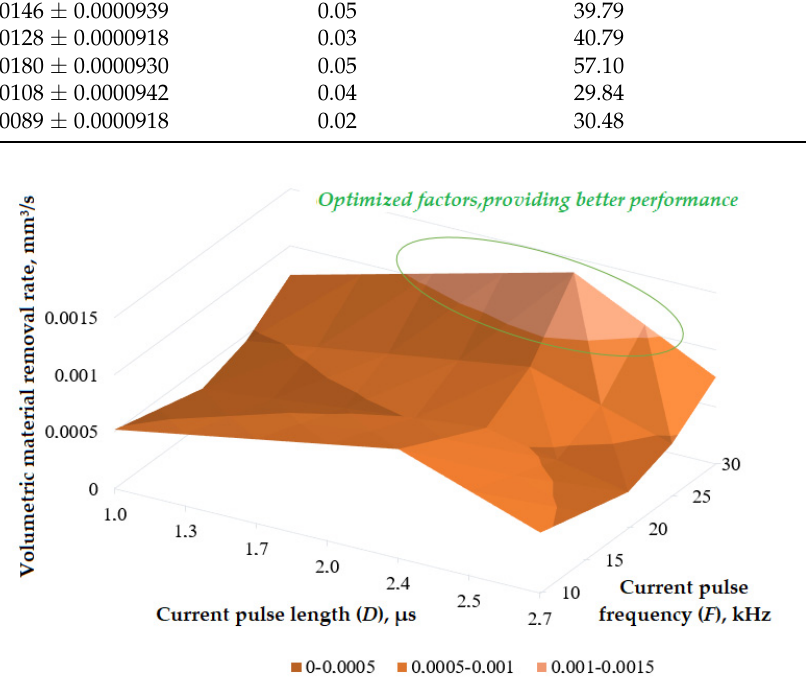
Figure 8. The performance of electrical discharge machining alumina using Ni-Cr coating and